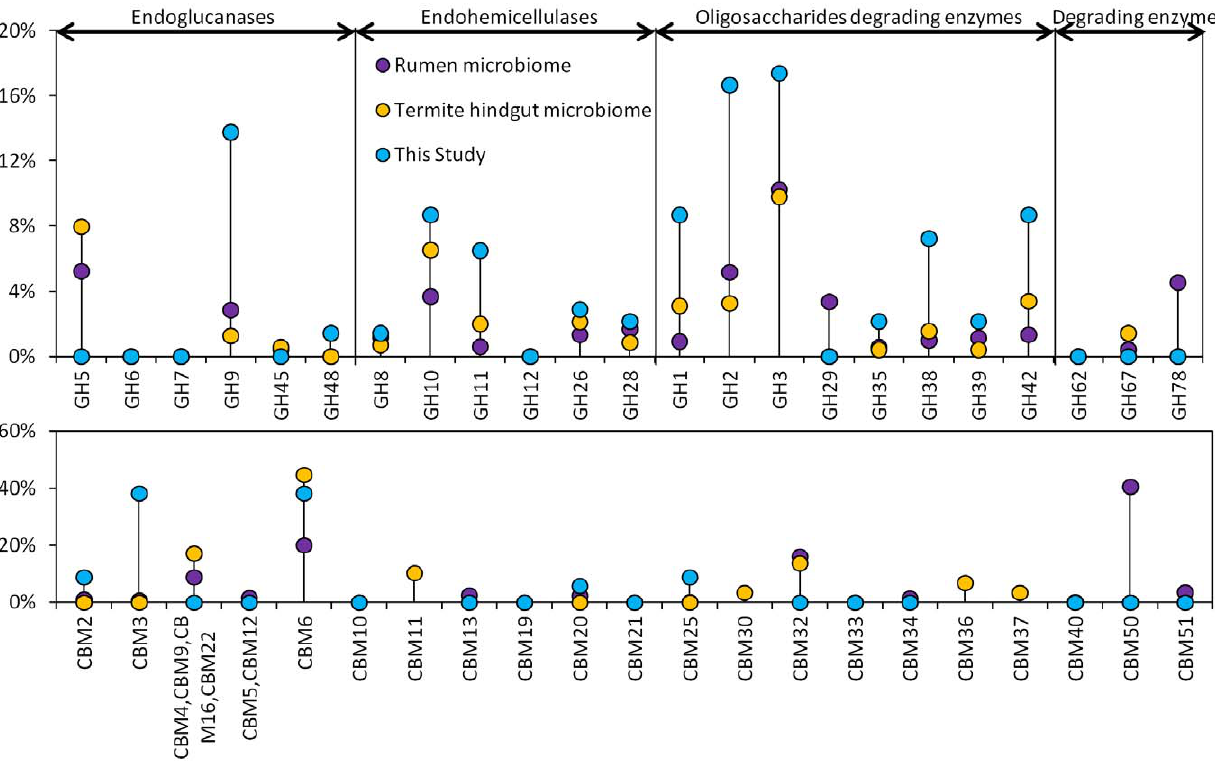
Figure 5. Comparison of predicted carbohydrate-active genes (top chart) and carbohydrate-binding modules (bottom chart) in three cellulosic materials fed metagenomes: rumen microbiome [ 11 ] , termite hindgut microbiome [ 12 ] and the enriched thermophilic cellulolytic sludge microbiome from this study. Glycoside hydrolase (GH) families are assigned to different categories based on the classification published by Pope et al. [19] PFAMs associated with particular GHs and CBMs are listed in Table S3 and S4. Gene counts include both complete ORFs and ORF fragments.